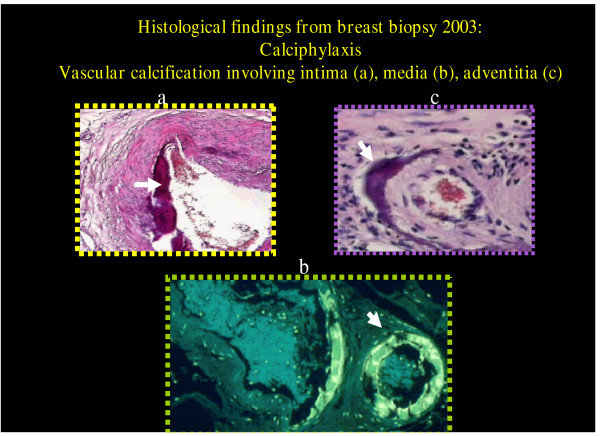
Histologic changes in a patient with CPLX and ESRD. Breast biopsy (benign) from a non-diabetic 60-year-old Caucasian female with an irregular breast mass 12 months prior to the development of clinical abdominal CPLX (multiple tumorous calcifications in the abdominal adipose tissue and skin ulceration). These tissue sections demonstrate the underlying systemic VOC of calciphylaxis. Her ulcerated area on the abdomen was not biopsied due to a possibility of aggravating tissue healing. Panel a: Demonstrates the H&E basophilic staining of intimal VOC in a small musculoelastic artery. Panel b: Demonstrates the medial fluorescent-like staining (due to inverted coloration of H & E basophilic staining) of VOC in an arteriole. Note the adjacent venule medial VOC staining. Venular VOC – thrombosis has not been as extensively studied as the arteriole and one must consider the possibility that VOC – thrombosis in the post-capillary venule may be important as the increased capillary edema and pressure may result in capillary endothelial dysfunction and promote an additive factor in the important role of subcutaneous ischemia and skin necrosis and ulceration. Note the panarteriolar involvement of the intima, media, and adventitia in the various vessels. Panel c: Demonstrates the H & E basophilic adventitial staining of VOC in an arteriole.